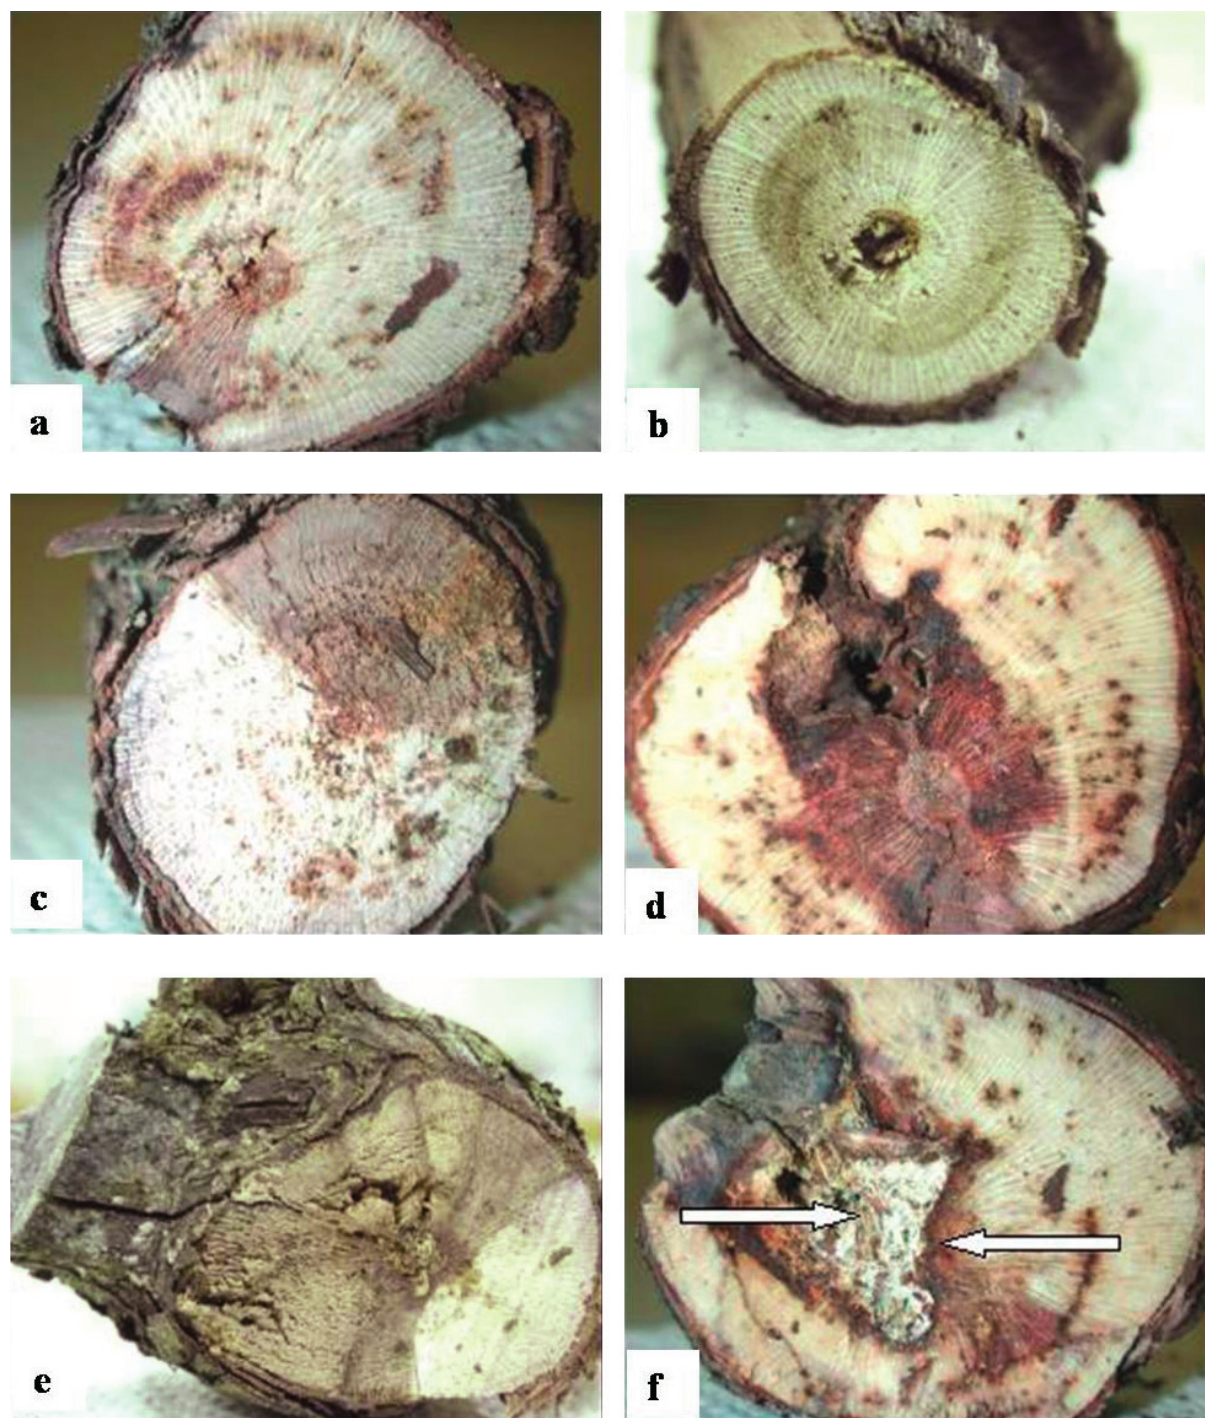
Figure 2. Cross sections made through cordon sections displaying various symptom types: a. black streaking, b. brown streaking, c. wedge-shaped necrosis, d. brown internal necrosis, e. watery necrosis, f. esca-like brown (left) and yellow soft wood rot